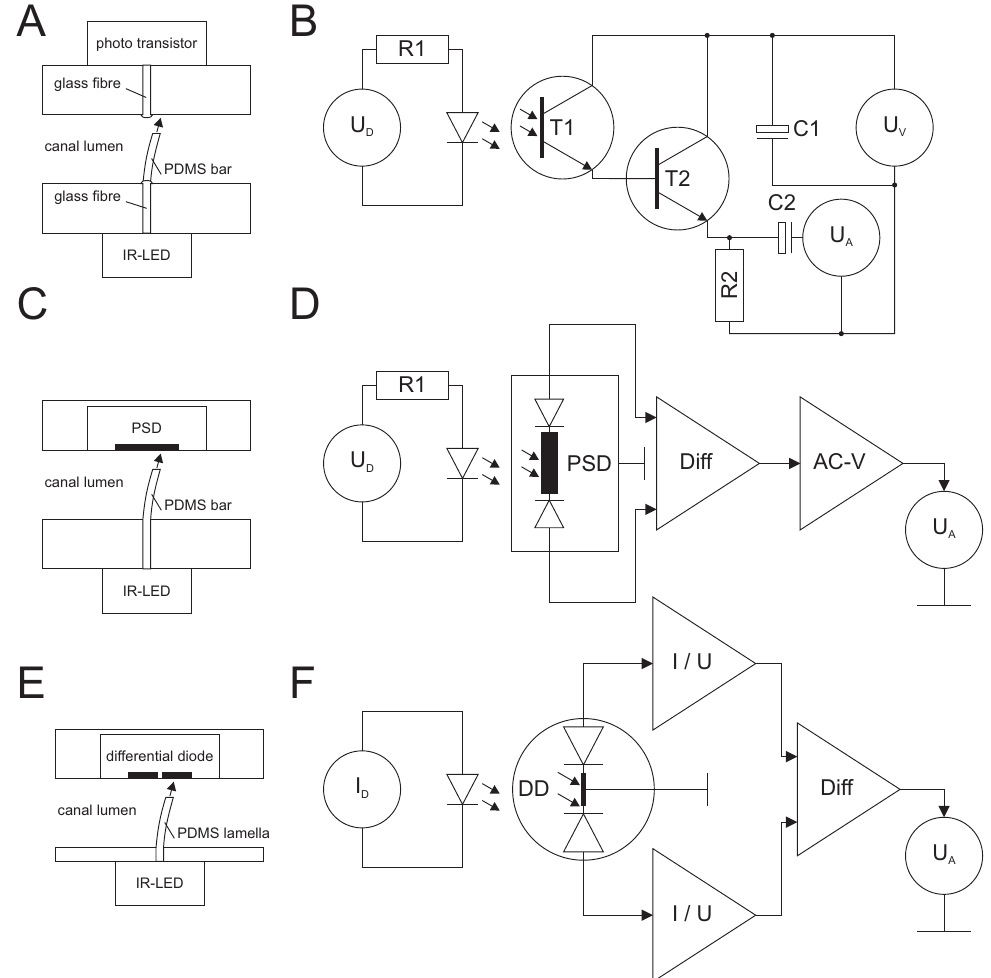
Figure 3. Optical read-out principles and sensor electronics. Various sensor read-out principles that were used to detect the deflection of the light-guiding PDMS lamella (left) and corresponding electronic circuits (right). ( A ) The photo transistor principle uses a Darlington configuration for amplification of the photo transistor current ( B ) (modified from [51]). ( C ) The position-sensitive photo diode (PSD) in photo cell operation mode in combination with a voltage subtractor and a capacitive coupled amplifier ( D ). ( E ) The differential photo diode (DD) combined with a trans-impedance amplifier followed by a voltage subtractor and a current source used for driving the LED ( F